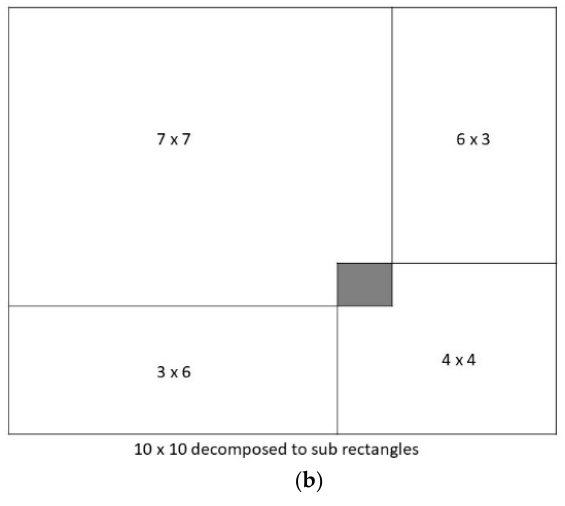
Figure 6. Image Argument for Lemma 4. ( a ) Decomposing a Modified rectangle with a 4 × 4 tiled modified rectangle; ( b ) A 10 × 10 modified decomposed rectangle.